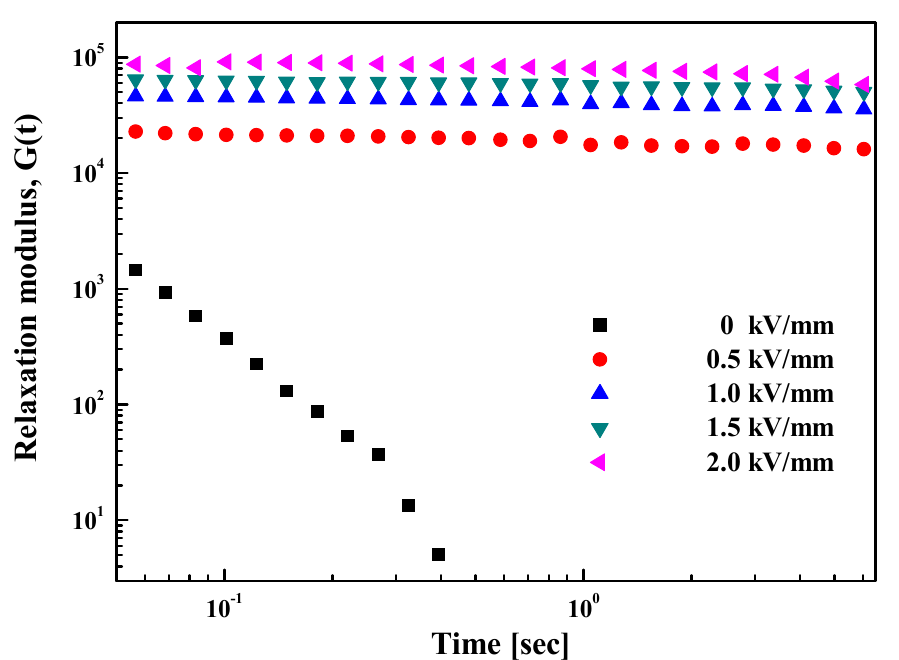
Figure 10. Relaxation modulus, G(t), of the core–shell particle-based ER suspension, obtained by the storage and loss modulus obtained from a frequency sweep test and using Equation (2), as a function of time.